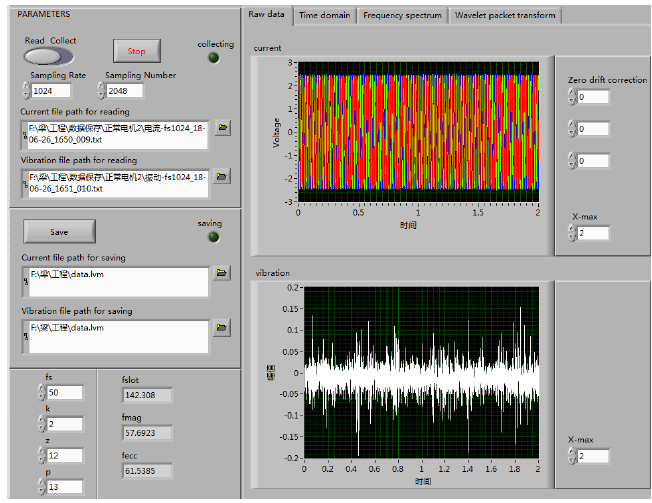
Figure 5. LabVIEW program for fault detection.